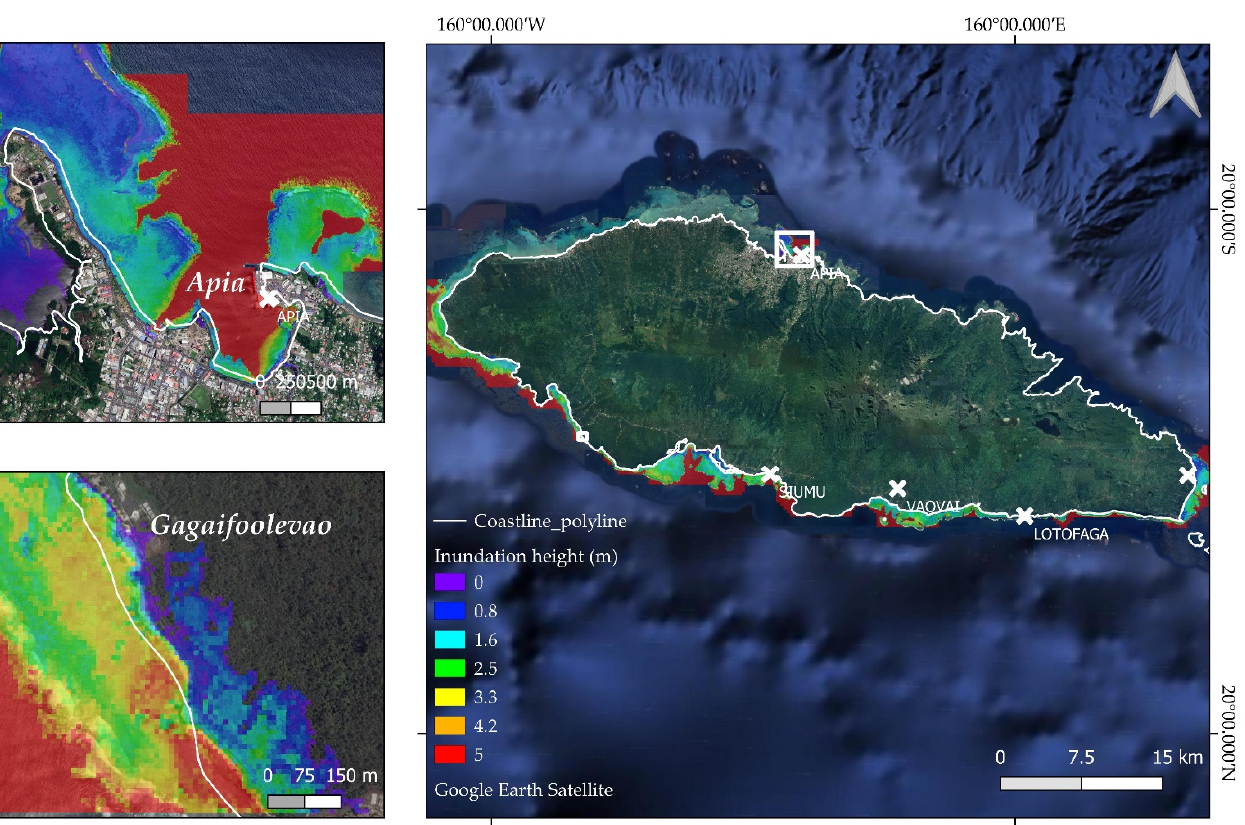
Figure 7. Inundation on Upolu in close-ups (10 m res.). The map shows the 10 m resolution run-up on Upolu ( a ) and in Apia ( b ), with the most severe inundation in Upolu close to Gagaifo’olevao ( c ).